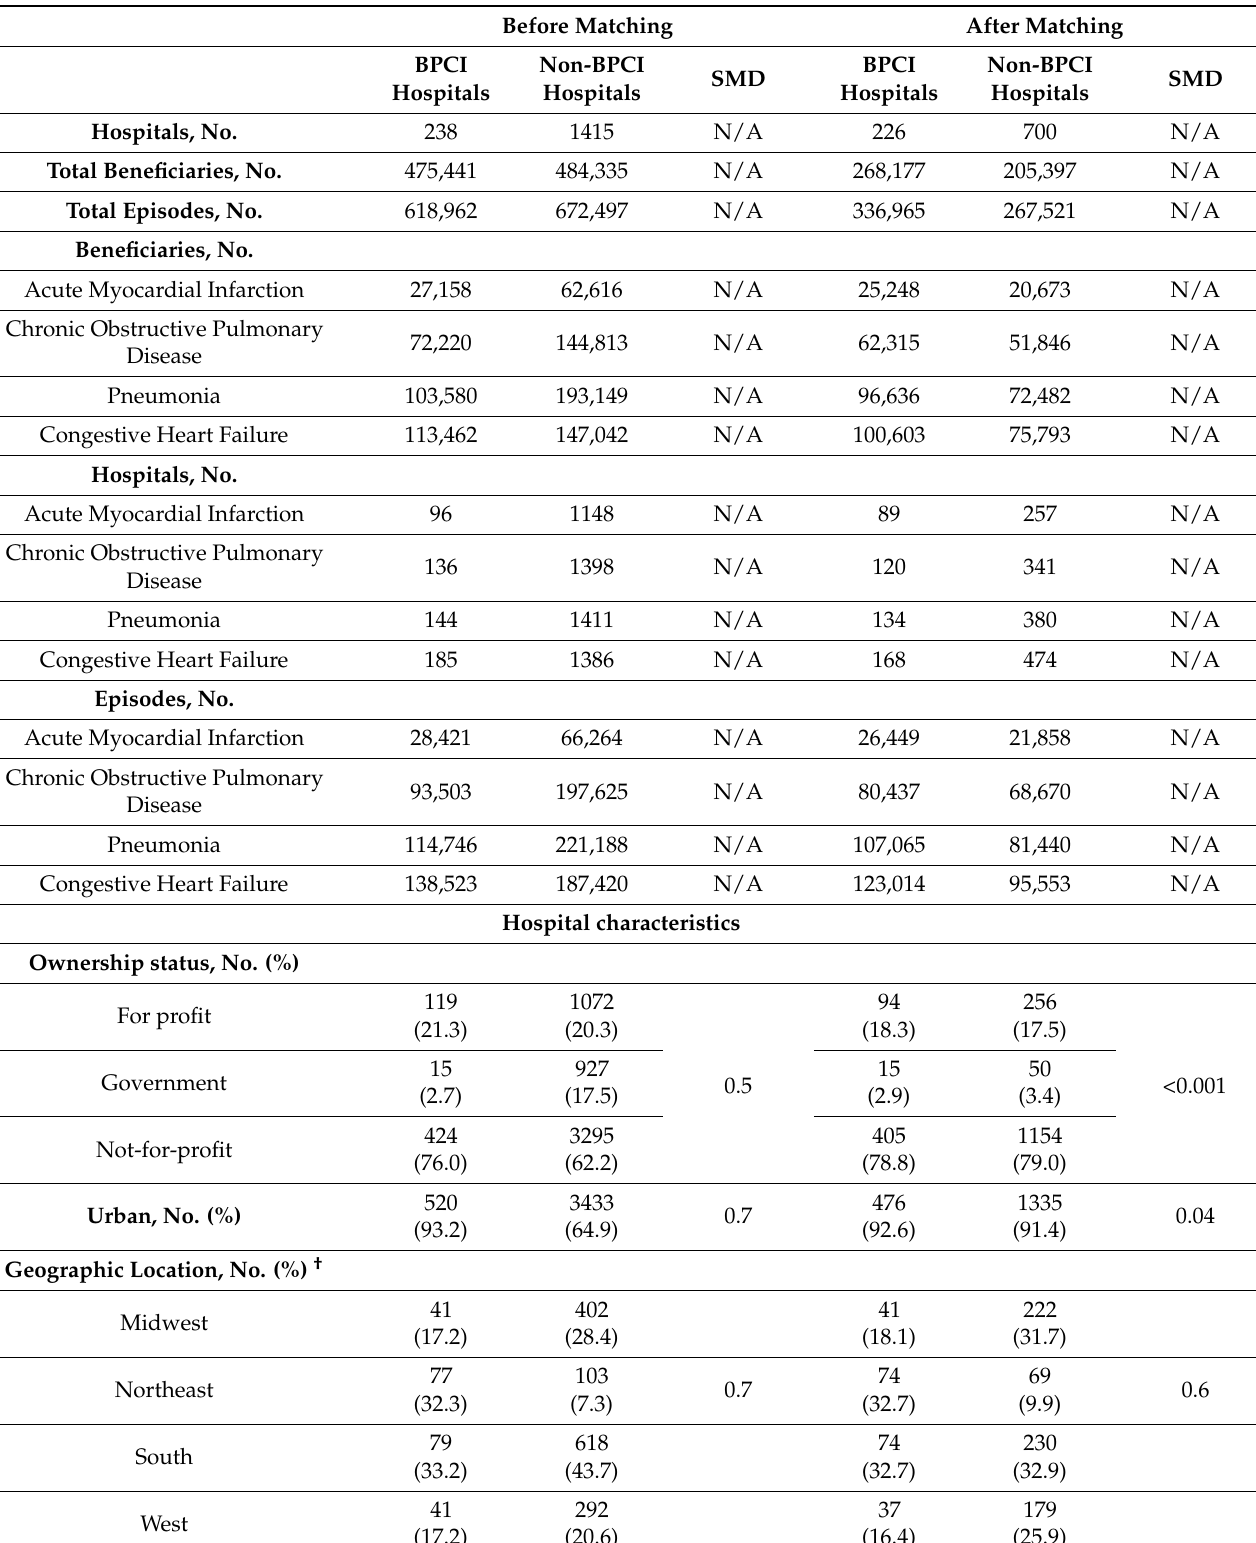
Table 1. Characteristics of BPCI and Non-BPCI Hospitals for Medical Condition Episodes, Before and After Propensity Score Matching